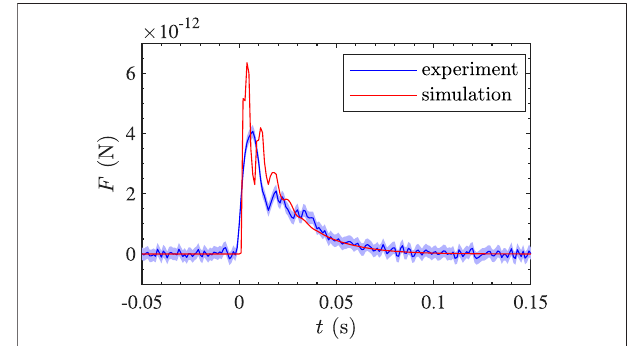
FIGURE 6 | Comparison of the magnitude of the unknown force measured in the experiment with 5.5 W plasma power and the simulated additional drag force caused by a pressure wave due to cooling of the plasma volume represented by a heating source of 2.0 W. The two show good